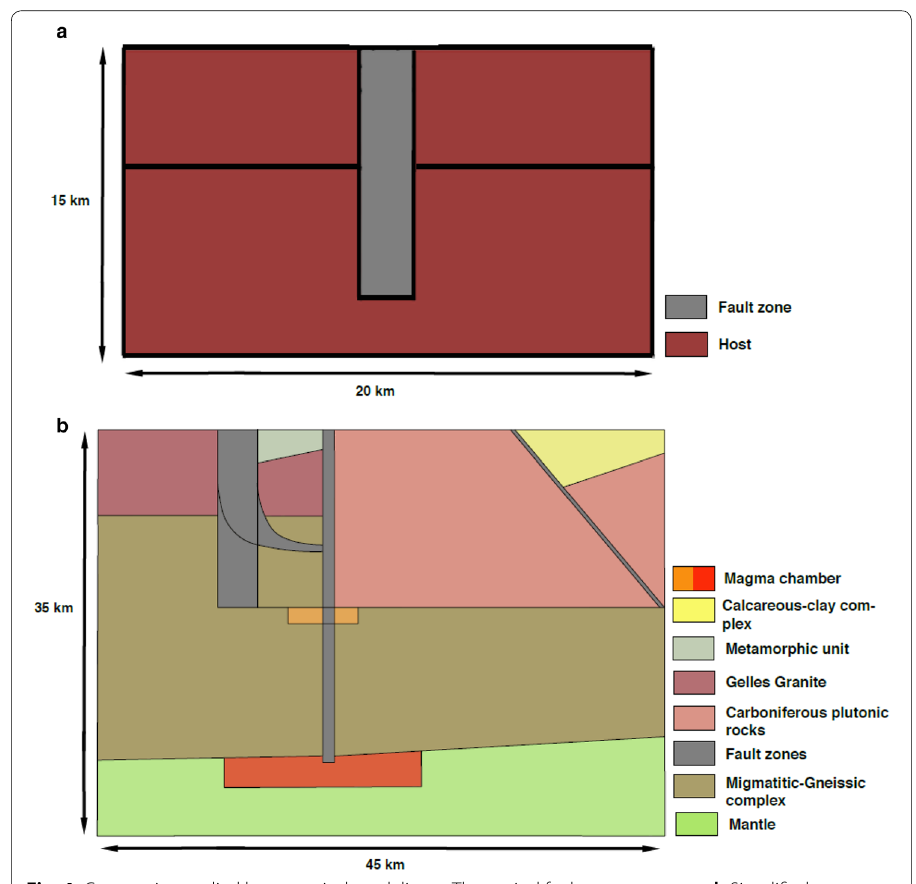
Fig. 4 Geometries studied by numerical modeling. a Theoretical fault zone geometry. b Simplified crustal‑scale geometry containing essential structural elements derived from field and geophysical data, and MT